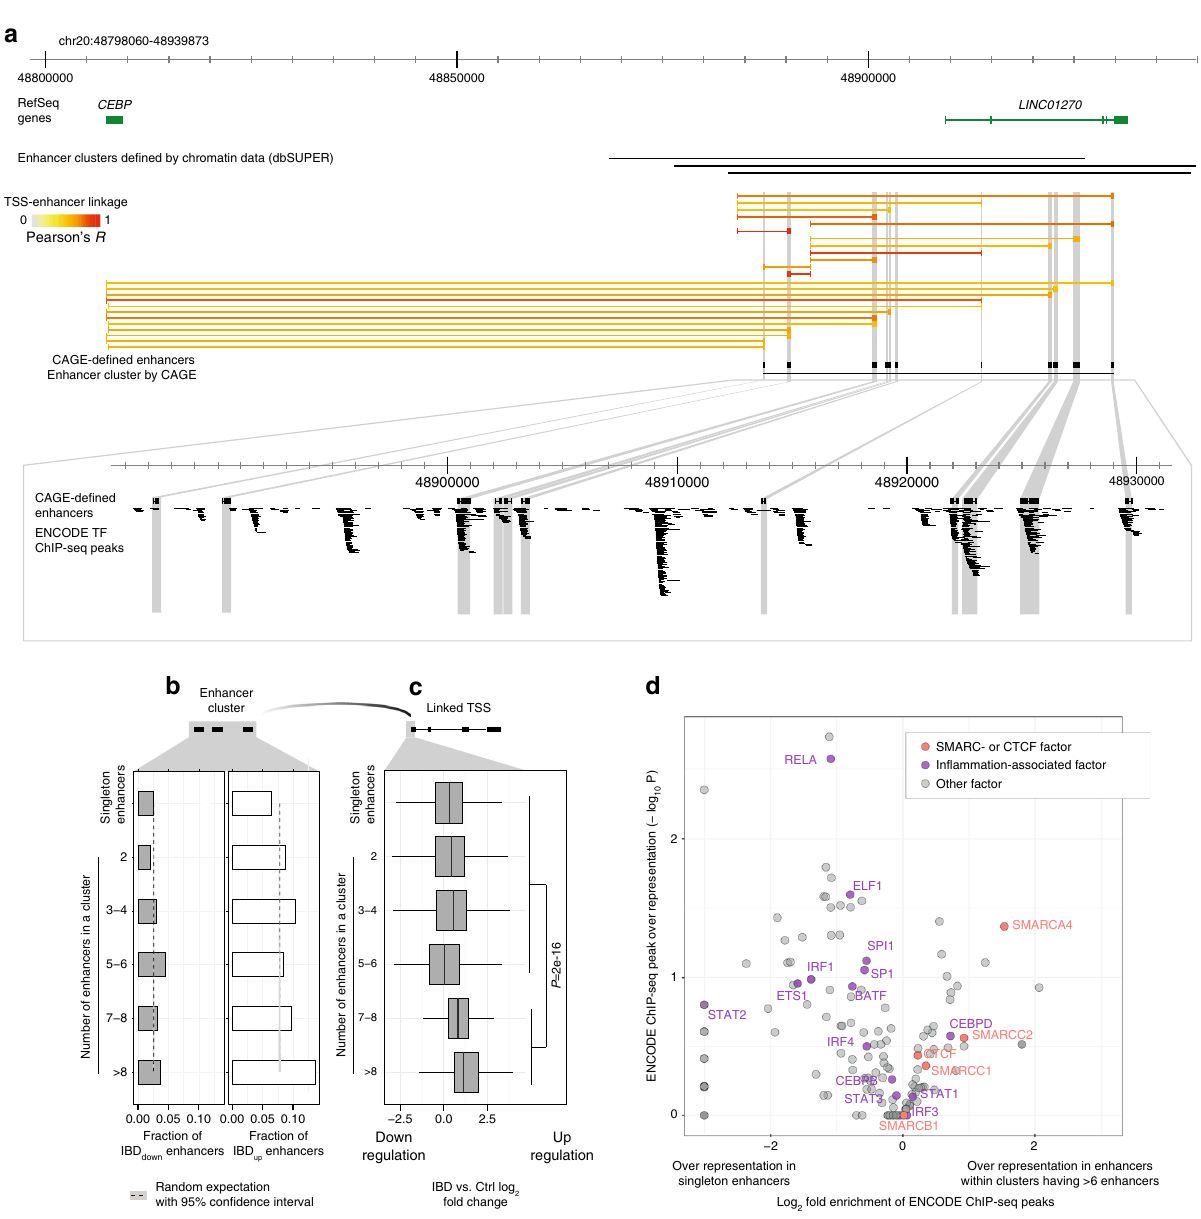
Fig. 5 Characterization of enhancer clusters in IBD. a Example of an enhancer cluster in the CEBPB locus. Genome browser screenshot of the CEBPB locus, organized as in a but also showing chromatin-de fi ned enhancer clusters from dbSUPER 36 , and a CAGE derived enhancer cluster located ~150 kb downstream of CEBPB . Because CEBPB has two nearby alternative TSSs with similar activity, most enhancers are linked to both. Lower panel shows a zoom- in of the enhancer cluster where ENCODE transcription factor ChIP-seq peaks are displayed: each black line corresponds to one ChIP-seq peak. b Relation between enhancer IBD-up/downregulation and number of enhancers within an enhancer cluster. Bar plot shows the fraction of enhancers that are signi fi cantly downregulated (IBD down , gray) or upregulated (IBD up , white) in UCa and CDa vs. Ctrl, grouped by the number of enhancers within an enhancer cluster. Enhancers not part of clusters are included for comparisons (singleton enhancers). The expected overlap by chance for each bar is indicated as dotted lines, with 95% con fi dence intervals. c Relation between the number of enhancers within an enhancer cluster and IBD upregulation of linked TSSs. Boxplots show the distribution of IBD vs. Ctrl log 2 fold changes of TSSs linked to singleton enhancers or enhancer clusters as in b . TSSs are grouped by how many enhancers the linked enhancer cluster contains. d Overrepresentation of ENCODE TF ChIP-seq peaks in singleton enhancers vs. enhancer clusters with >6 members linked to IBD-upregulated TSSs. X -axis shows the log 2 fold change in ENCODE ChIP-seq peak over-representation in single enhancers vs. enhancers within enhancer clusters having >6 enhancers, where 0 indicates no difference between sets. Only enhancers linked to IBD up TSSs are analyzed. Y -axis shows the associated over-representation P -value. Each dot corresponds to one type of ChIP-seq peak, colored by whether they are annotated as in fl ammation-associated factors (purple), SMARC- or CTCF factors (orange), or other factors (gray). Factors of interest are